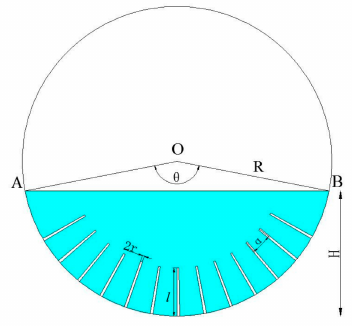
Figure 6. The average flow velocity of the flocking drainage pipe